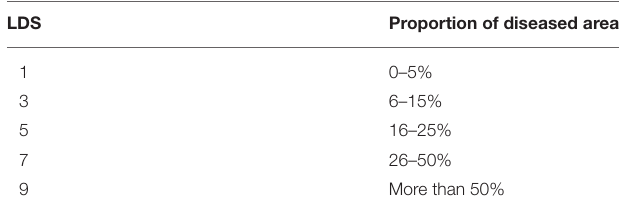
TABLE 1 | Classification of leaf disease